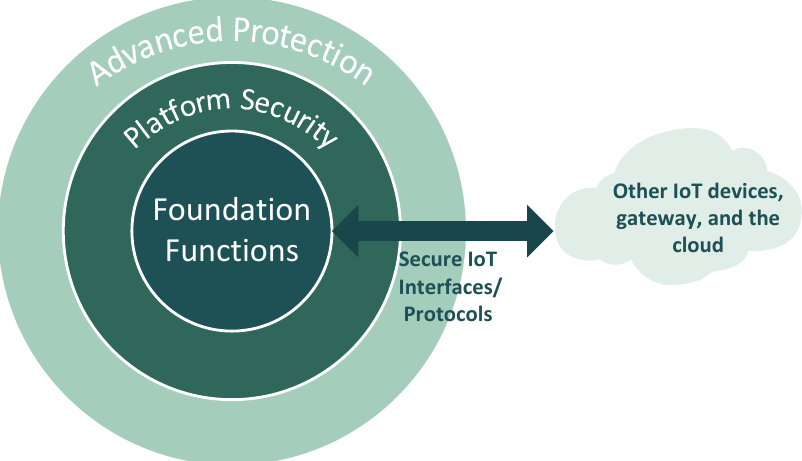
Figure 2. Layered overview of IoT main classes of security technologies (adapted from